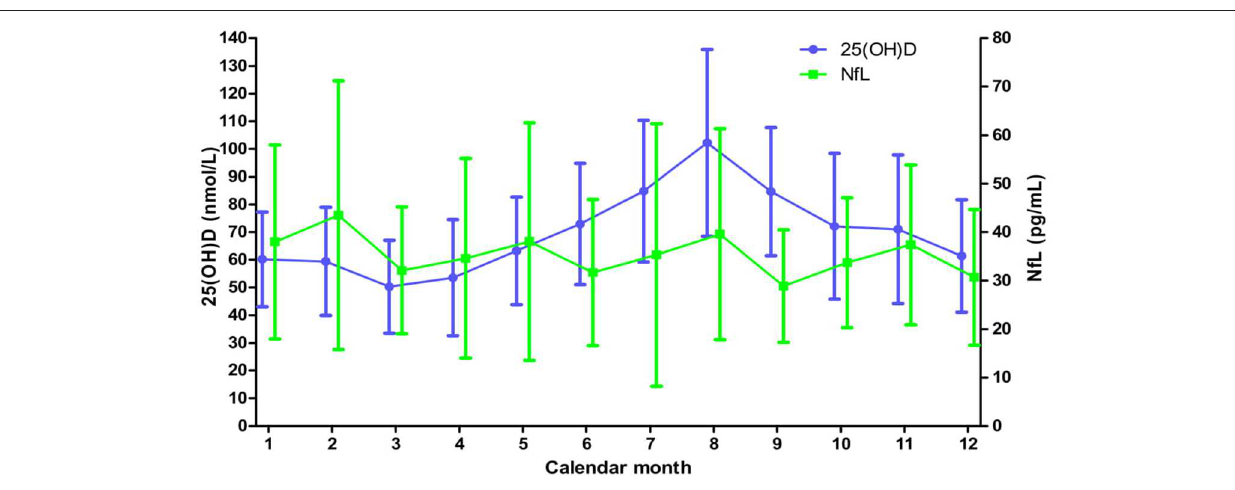
Frontiers in Neurology |